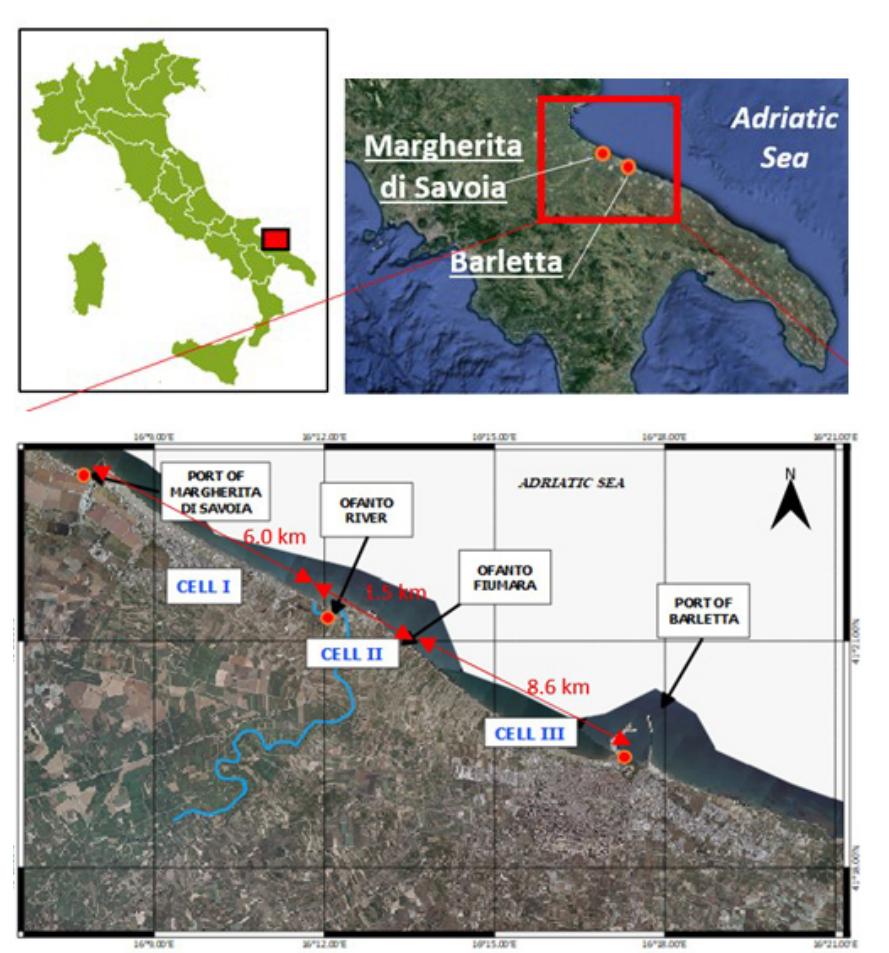
Figure 2. Study area with notation of Cell I–Cell III. Source © Google